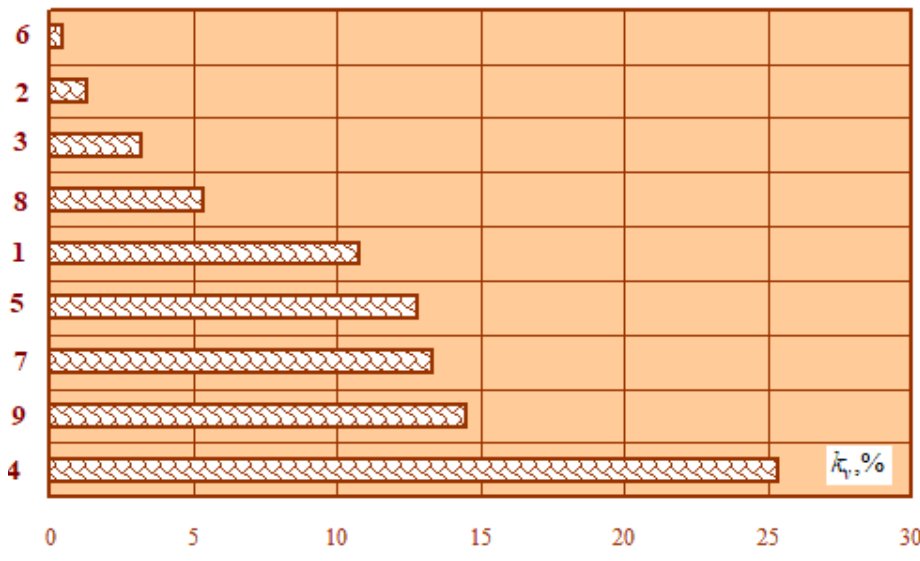
to those of Figure 15.